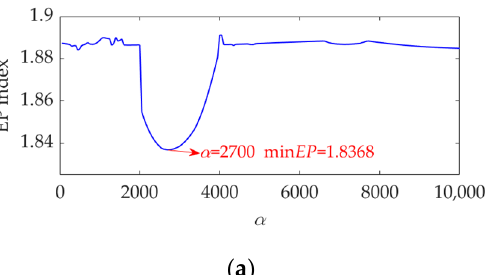
Figure 24. Results of the vibration dataset associated with the ball fault obtained using SVMD with α opt = 2700.